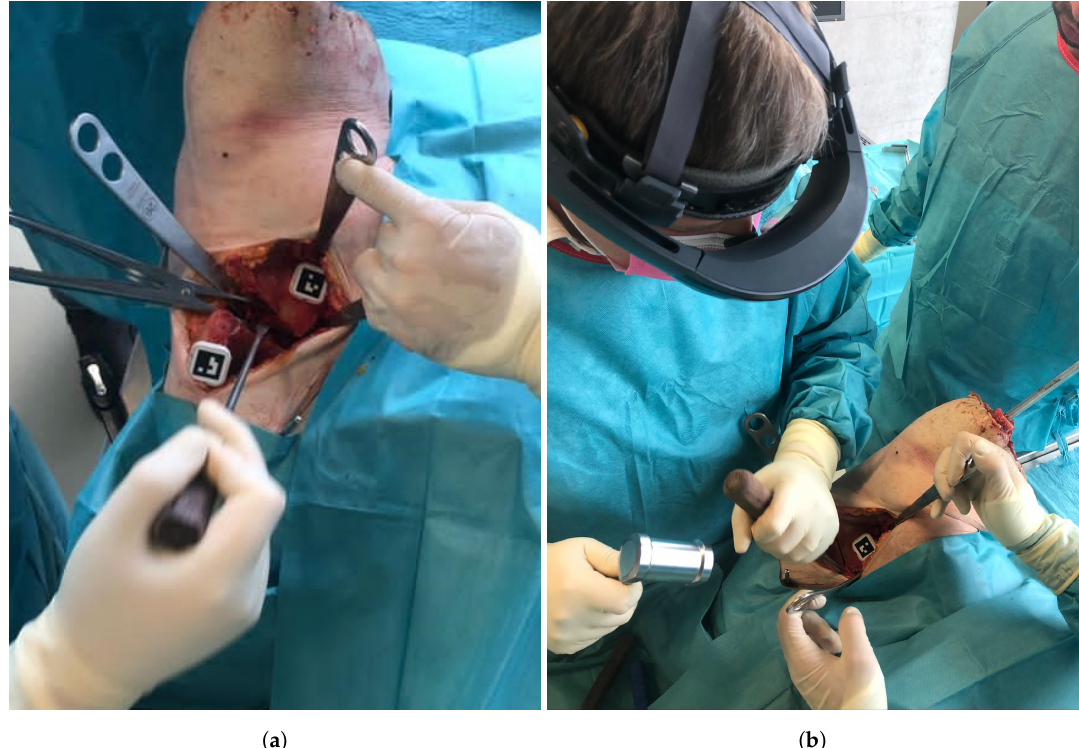
Figure 4. ( a ) The pelvic and fragment mounts equipped with markers and fixated to the anatomy. ( b ) The surgeon during the procedure wearing the